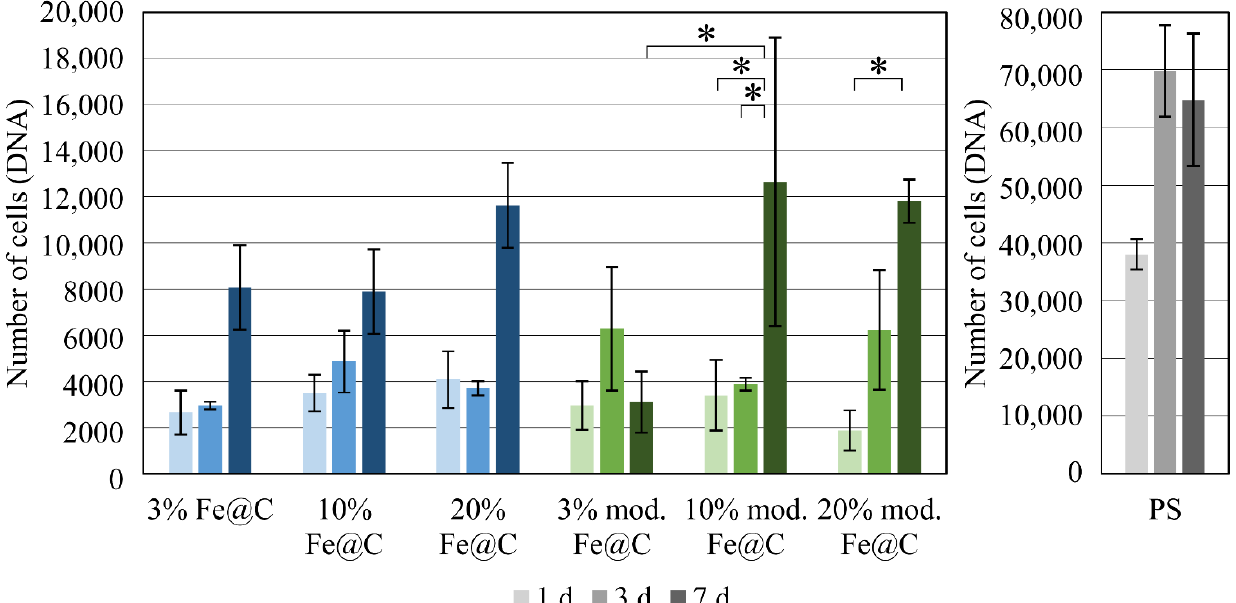
Figure 2. Cell counts as means ± standard deviation calculated from DNA measurements after HUVEC culture over one, three, and seven days on stainless steel coated with PLA containing 3%, 10%, and 20% non-modified Fe@C NPs (blue) and chemically modified Fe@C NPs (green). HUVECs cultured on well plate polystyrene (grey) is used as positive reference. Asterisks (*) indicate statistically significant differences ( p < 0.05).